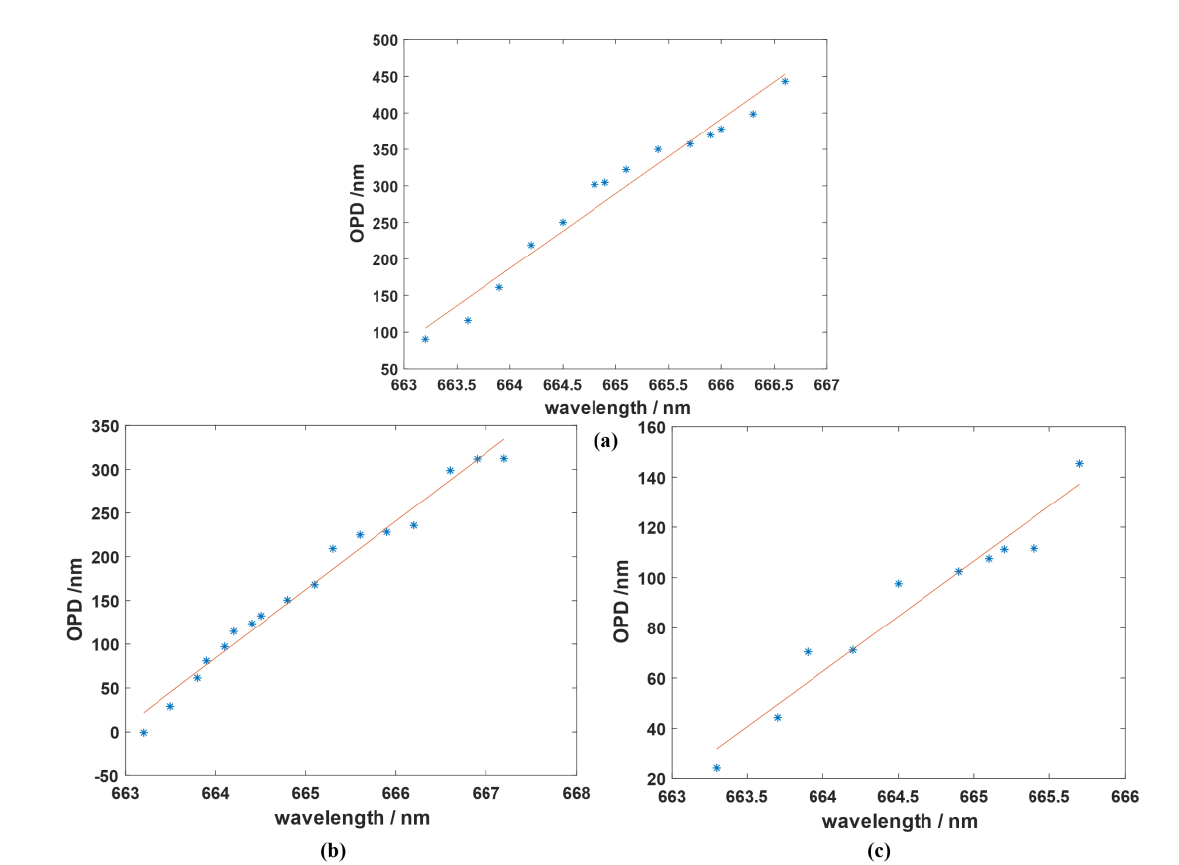
Figure 7. Piston error experimental result. ( a ) Original case; ( b ) 10 μm piston input; ( c ) 20 μm input.